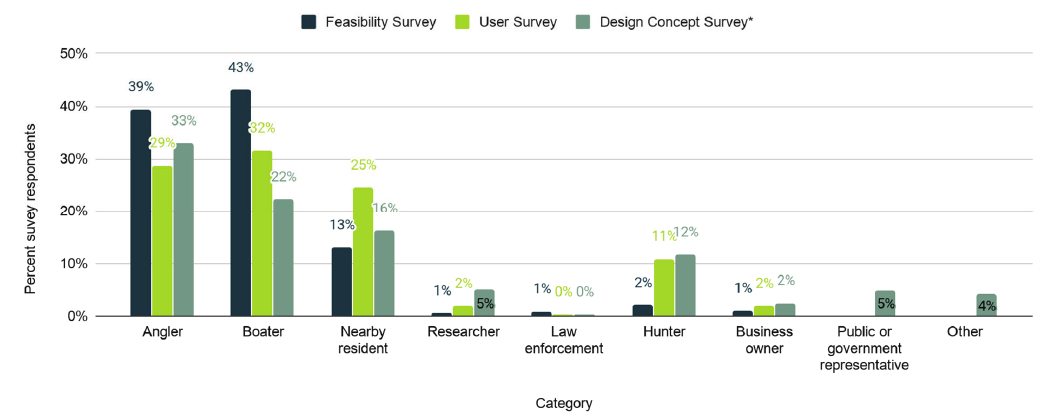
Figure 17. Comparing participant categories across